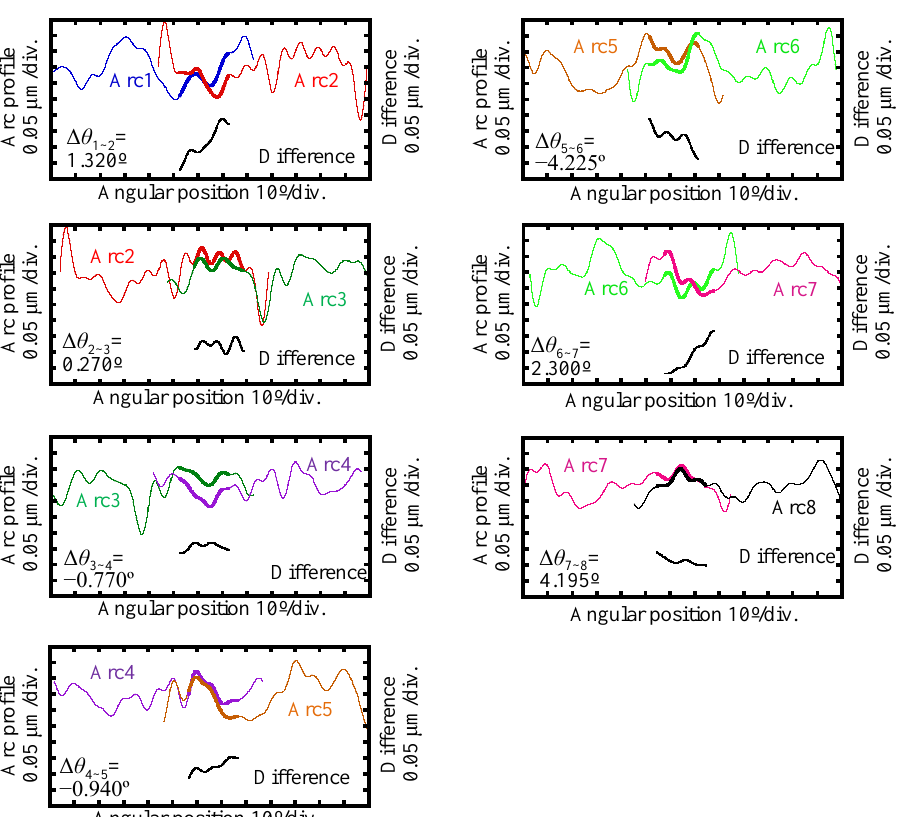
Figure 19. Stitched neighboring arc-profiles from the eight arc-profiles obtained by measuring the workpiece with a diameter of 1.5 mm.